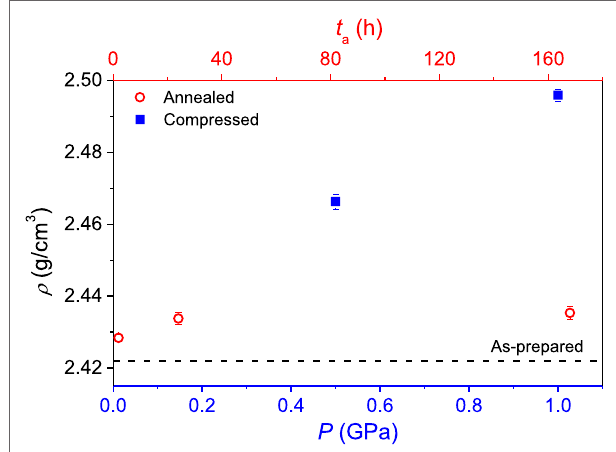
FigUre 1 | Dependence of density ( ρ ) on the thermal and pressure histories prior to ion exchange . Annealing duration ( t a ) and maximum pressure ( P ) are varied to obtain a wide range of density values. The density value prior to annealing or pressure quenching is indicated by the dashed